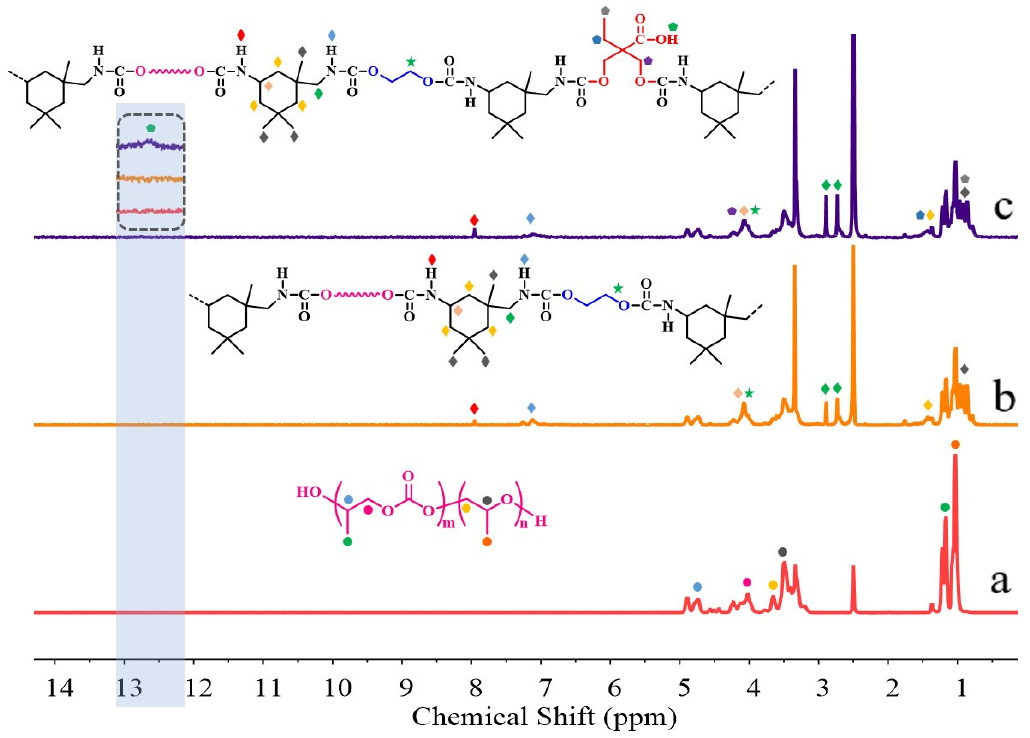
Figure 3. 1 H NMR spectra of ( a ) PPCD, ( b ) 0-DMBA-TPU, and ( c ) 2-DMBA-TPU.